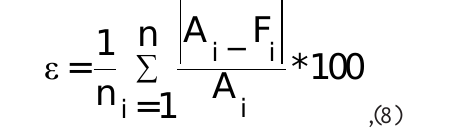
–data for October o